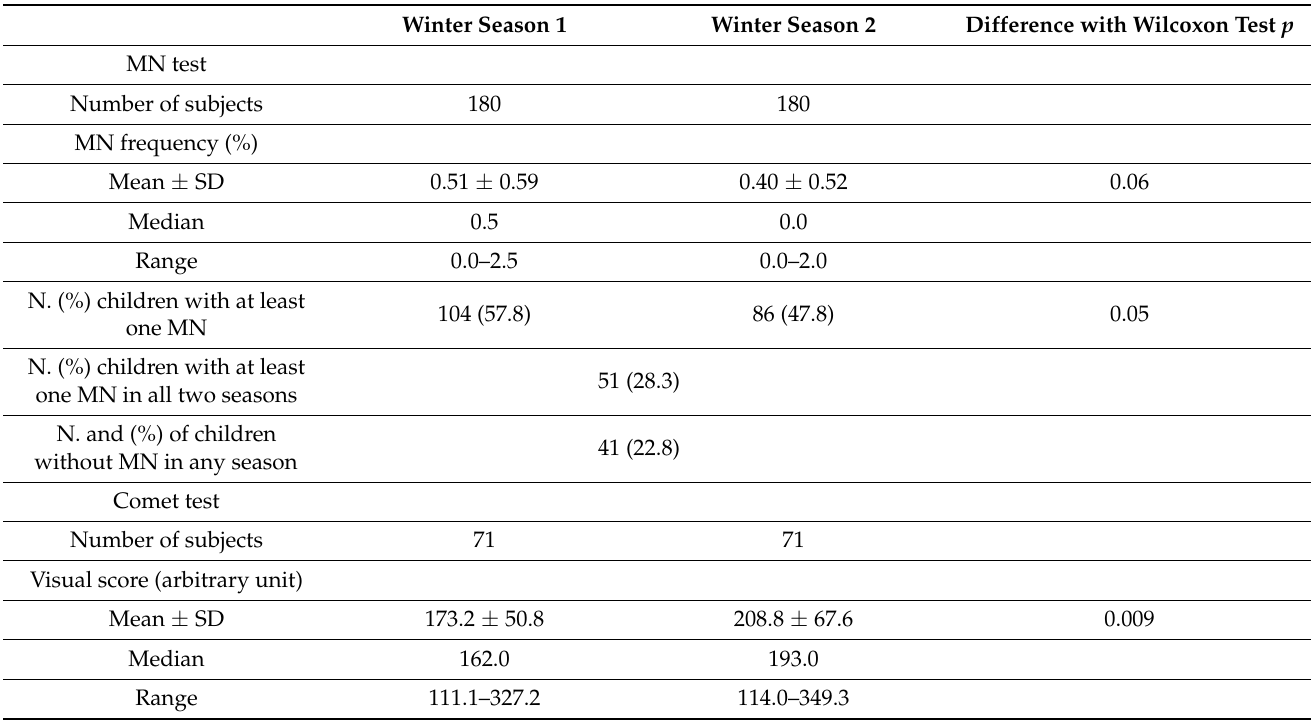
Table 2. Distribution of MN in children’s buccal mucosa cells and visual score in comet test in salivary leukocytes in the two